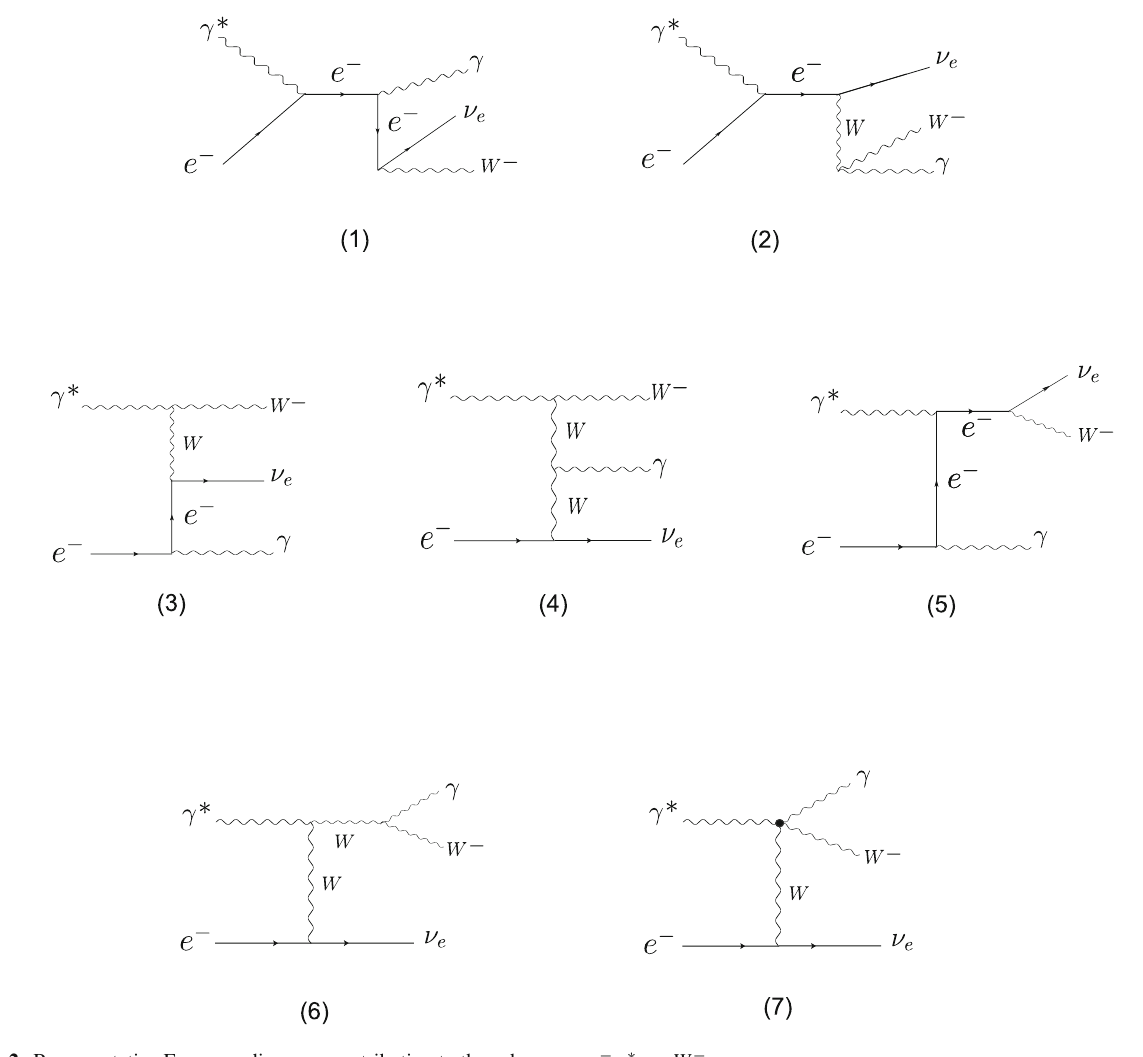
Fig. 2 Representative Feynman diagrams contributing to the subprocess e − γ ∗ → W − γν